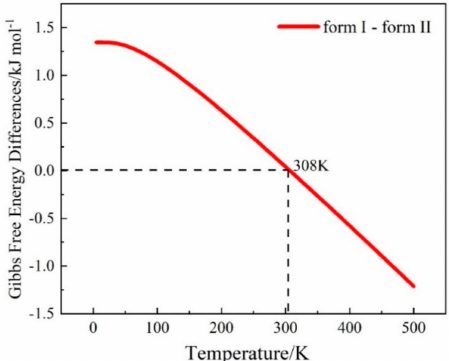
Figure 5. The calculated Gibbs free energy di ff erences of β -lactam per unit cell between forms I and II (form I–form II) from 0 to 500 K at standard atmospheric pressure (100 KPa), where the temperature-induced polymorphic transformation occurs at 308